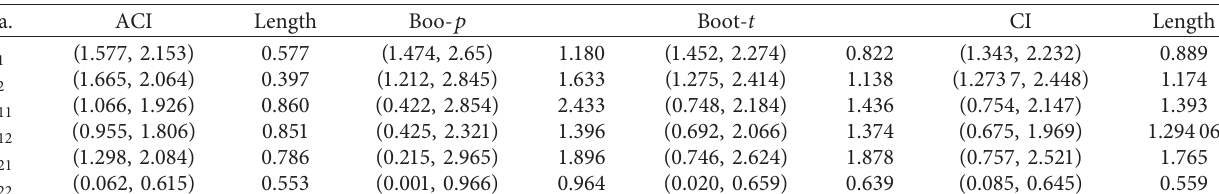
Table 4: 95% ML, bootstrap, and Bayes interval estimate.